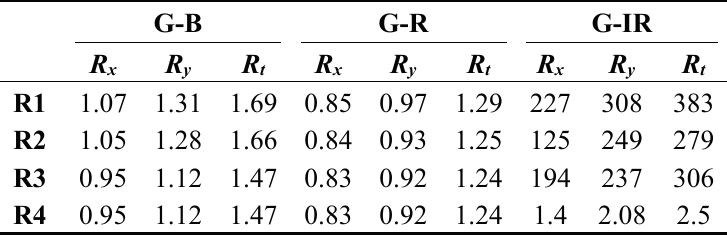
Figure 19. The CIR composite of the four-band images; ( a – c ) respectively the multispectral images obtained by using the methods using the first-order polynomial, second-order polynomial and homography model and using the RANSAC directly; ( d ) the multispectral images obtained by using our method. Table 4. The errors for registering near infrared, red and green band to the blue